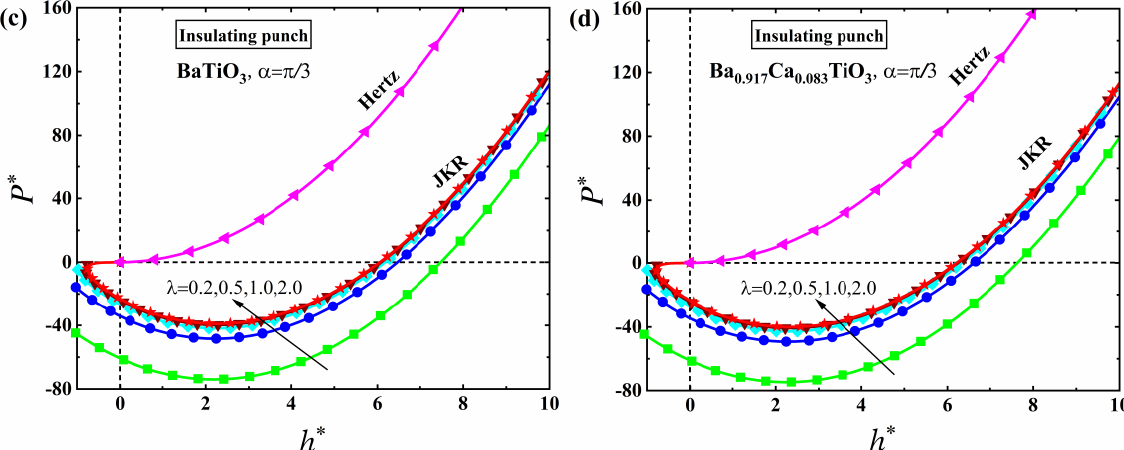
Figure 17. The dimensionless indentation force, P ∗ , as a function of the dimensionless indentation depth, h ∗ , under the action of an insulating punch for the M-D model. ( a ) PZT-4. ( b ) PZT-5A. ( c ) BaTiO 3 . ( d ) Ba 0.917 Ca 0.083 TiO 3 .